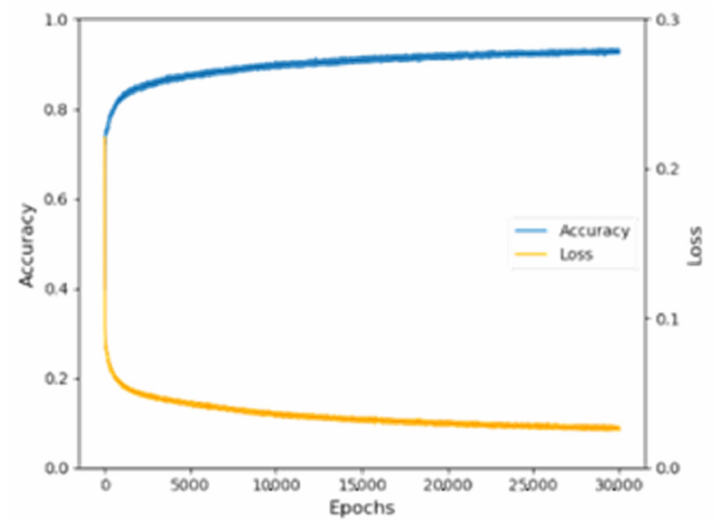
Figure 5. Variation diagram of the training set accuracy and Loss